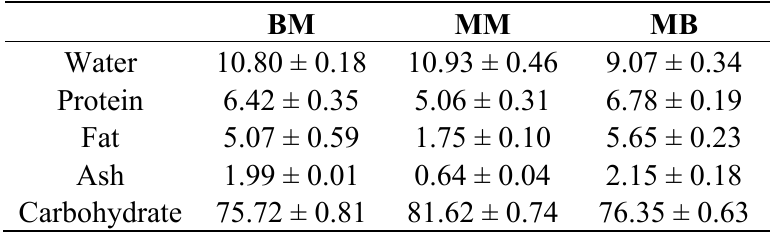
Table 2. General compositions of BM, MM and